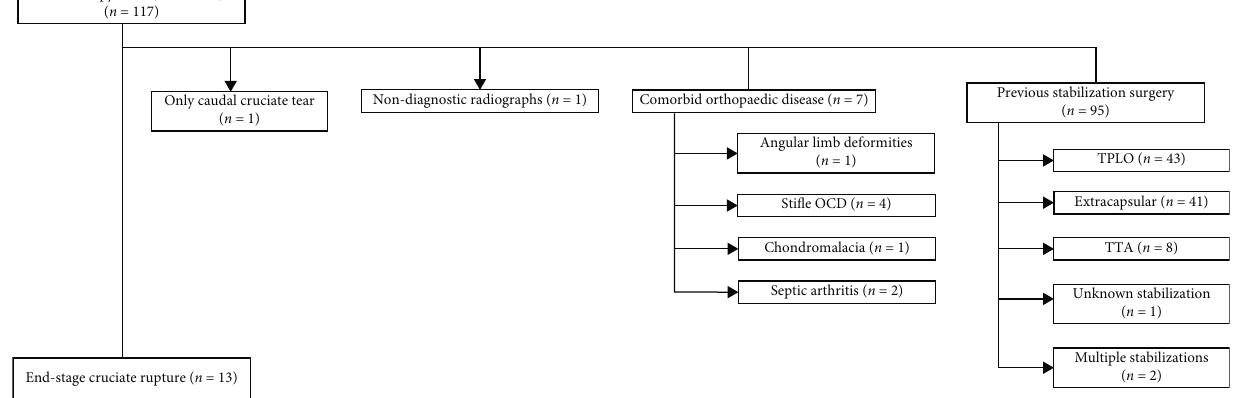
Figure 1: Flow diagram for case inclusion and exclusion. Of the 117 cases identi fi ed from the initial medical record search of arthroscopy cases, 13 dogs were included in the analysis. Table 1: Clinical examination fi ndings in 13 dogs treated with arthroscopy for chronic CR.